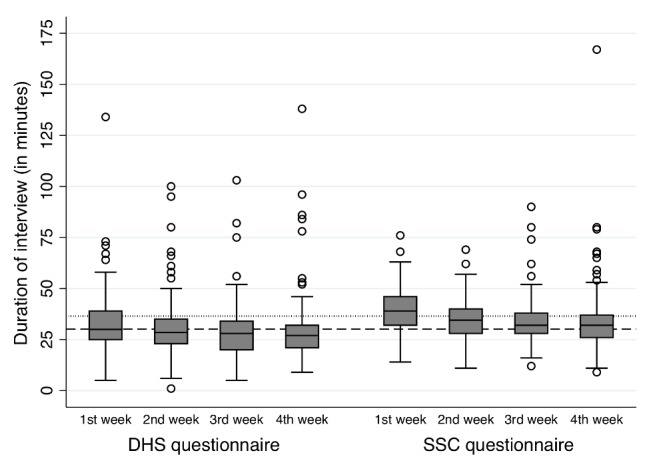
Distribution of interviewing time by study group and week of fieldwork.In this figure, the bottom and top of each box represents the first and third quartiles of the distribution of interviewing time, and the middle line represents the median. The whiskers represent the most extreme values within 1.5 times the interquartile range; circles represent outliers. Two interviews reported to have lasted 472 and 625 min are excluded from these figures for visualization purposes, but were included in calculations of median time. These interviews lasted exceptionally long because they were discontinued and the interviewer subsequently left the respondent's house at the time of interruption. The interviewer later returned to finish the interview, but did not record the time at which they discontinued the interview, nor did they record the time at which they resumed it. As a result, the actual interviewing time is not known. Five interviews reported to have lasted more than 100 min are included in this graph. These interviews were also momentarily interrupted, but the interviewer remained at the respondent's house until completing the interview. Data on interview duration were missing for 45 interviews. Of these, 24 were in the DHS group (3.9%) and 21 were in the SSC group (3.7%).